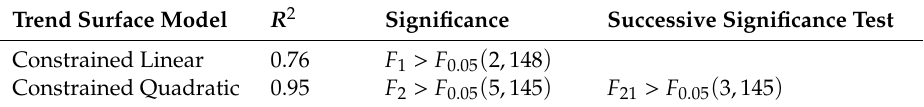
Table 2. Statistical tests of constrained linear and quadratic fitting of the trend surfaces of grid (35, 317). Trend Surface